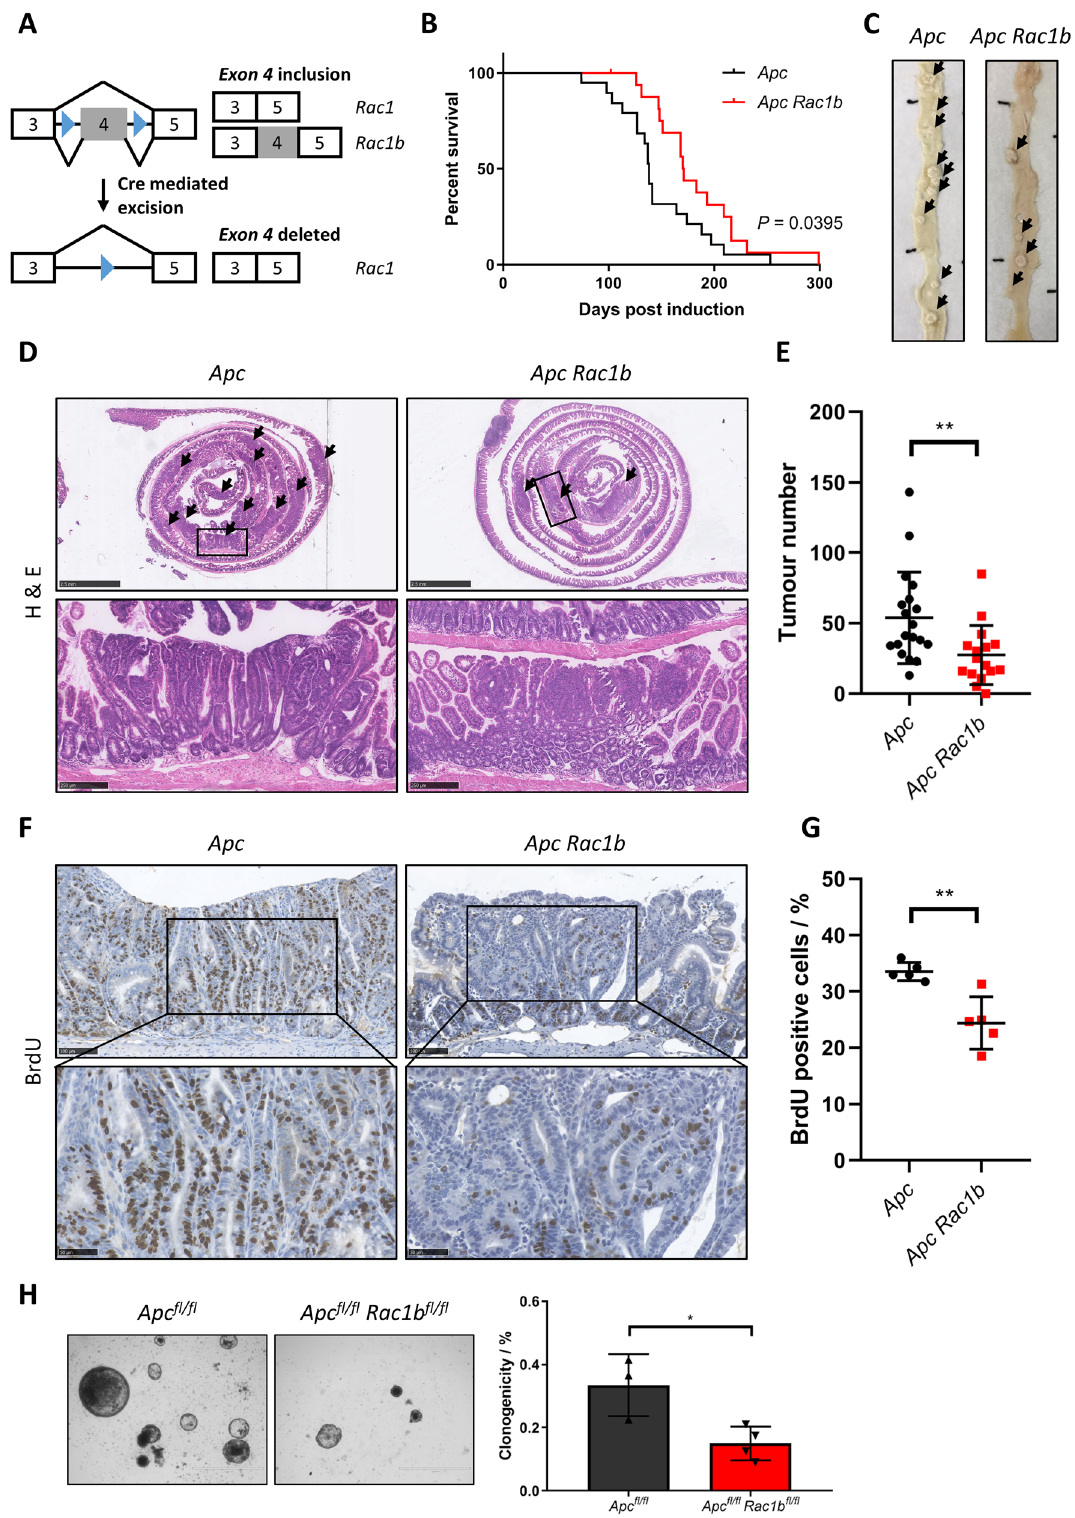
To identify potential pathways mediated by Rac1b expression involved in tumorigenesis, we carried out RNAseq analysis on 4 vs 4 small intestinal tumours dissected from Apc and Apc Rac1b mice (con fi rmed negative for Rac1b by qRT-PCR). This analysis identi fi ed 506 mRNAs with signi fi cantly altered expression (fold change > 1.5, padj < 0.05). Of these, 265 had signi fi cantly increased expression and 241 had signi fi cantly